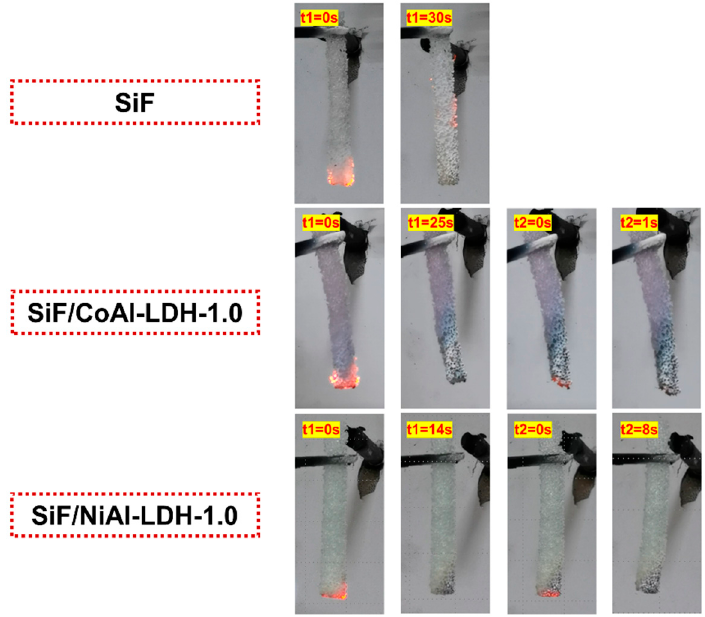
Figure 5. Video snapshots of the SiF/LDH nanocomposites during vertical flame